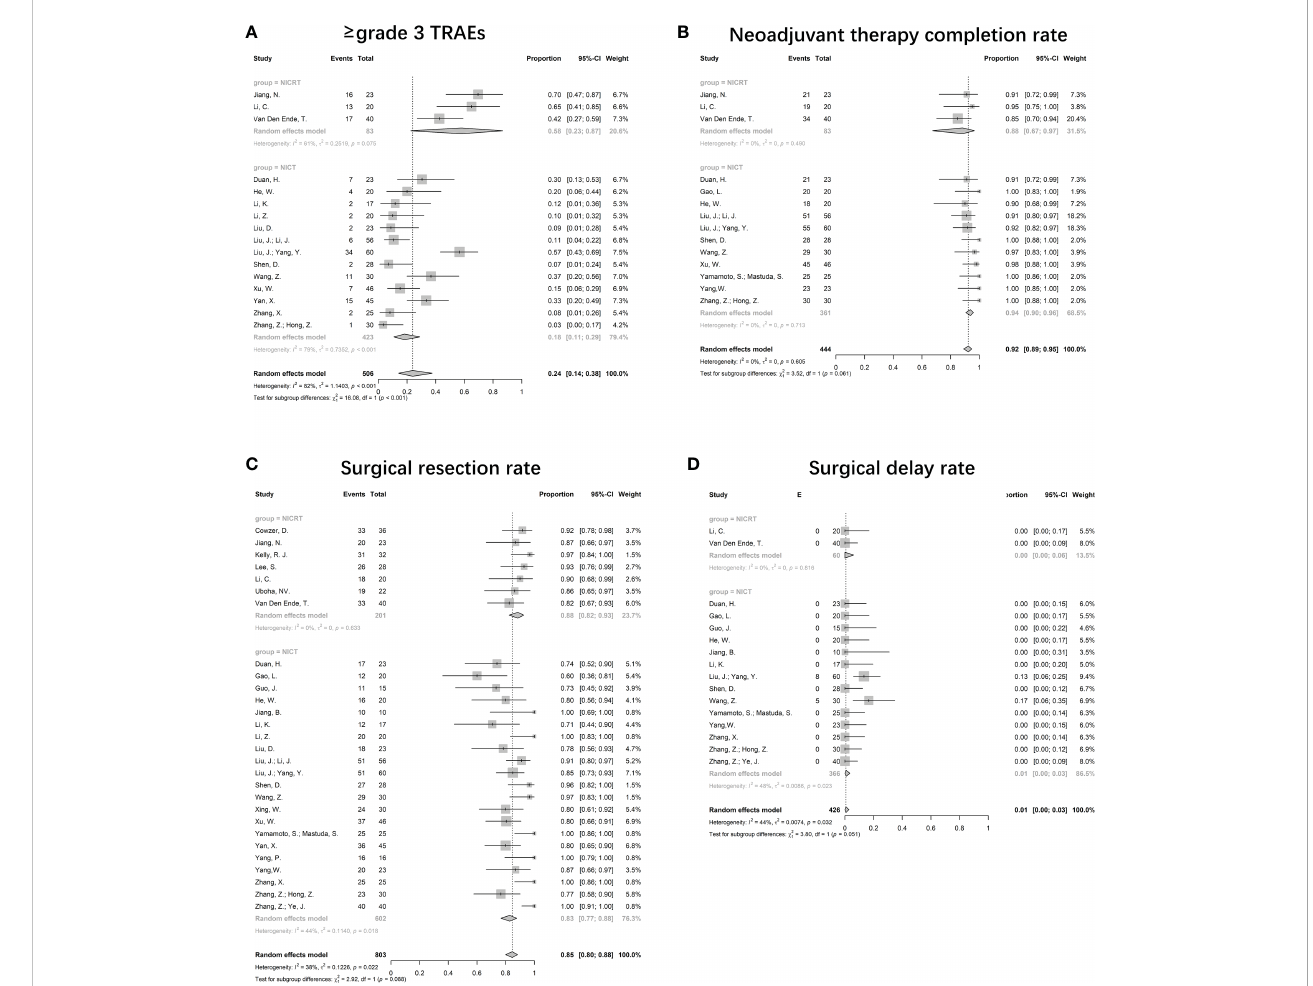
FIGURE 4 Forest plots for safety. (A) Incidence of ≥ grade 3 TRAEs, (B) Neoadjuvant therapy completion rate, (C) Surgical resection rate, and (D) Surgical delay rate. NICRT, neoadjuvant immune-chemoradiotherapy; NICT, neoadjuvant